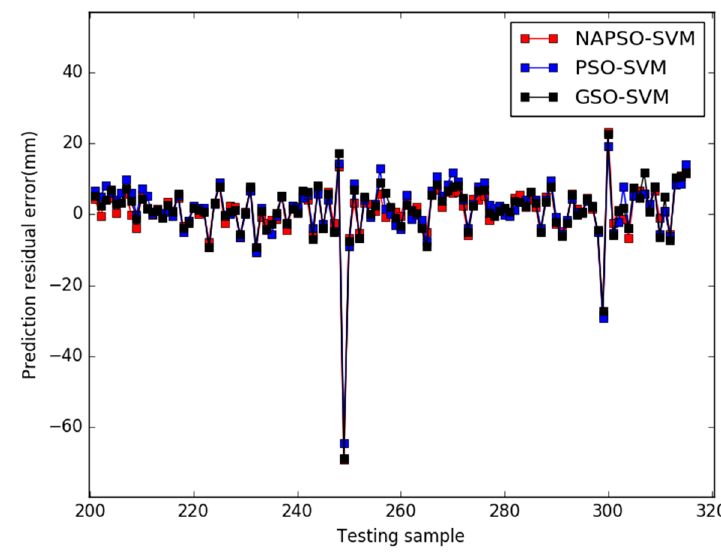
Figure 8. Comparison of the predicted residuals of the three models (case 2).